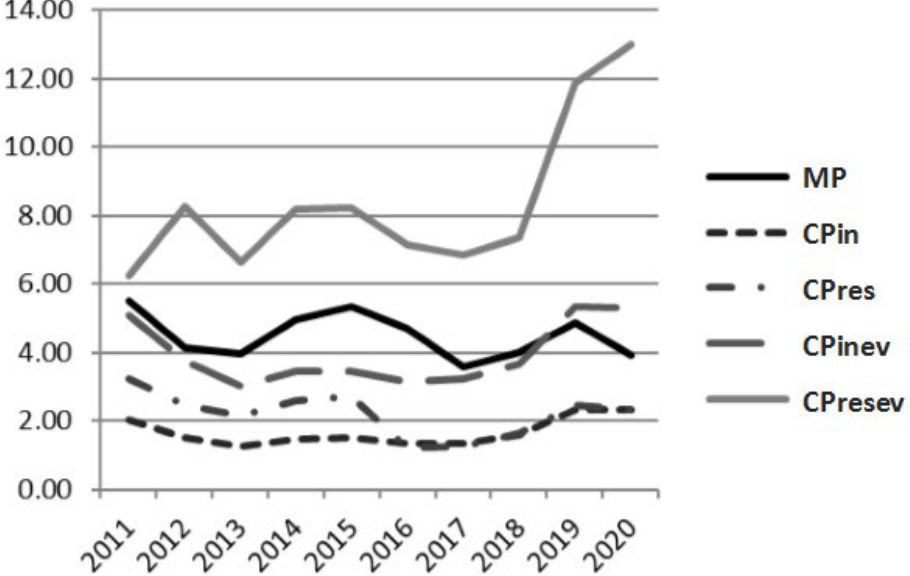
Figure 3. Material and capital productivity value dynamics for the PJSC “Norilsk Nickel”. MP—material productivity; CPinev—indicator calculated based on initial CP values of machinery and equipment; CPresev—indicator calculated based only on the residual cost of the machinery and equipment.